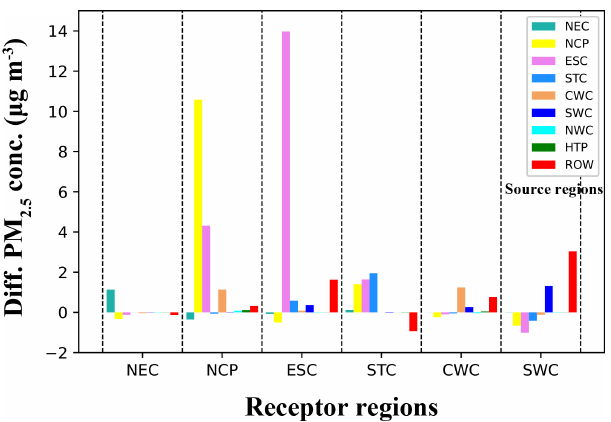
Figure 8. Composite differences in near-surface PM 2 . 5 concentra- tions (µm − 3 ) averaged over receptor regions (marked on the hori- zontal axis) in China between the most polluted and normal days in February 2020 originating from individual source regions (corre- sponding color bars in each